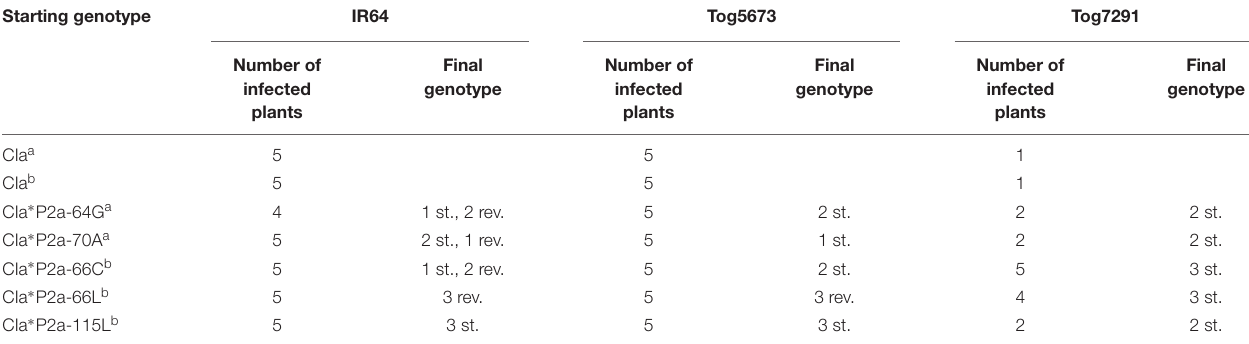
TABLE 5 | Fitness of mutants obtained by directed mutagenesis and two successive multiplications on IR64. Starting